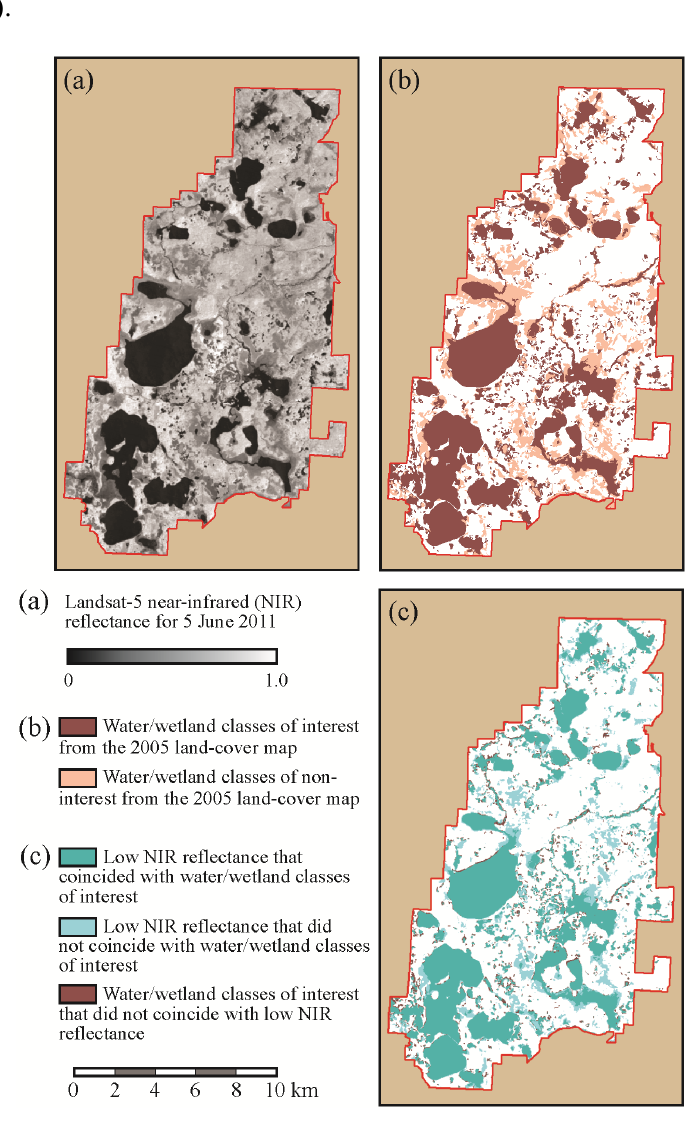
Figure 4. Comparison of early-season near-infrared (NIR) band reflectance ( a ) in 2011 with the distribution of water/wetlands from the 2005 land-cover map; ( b ) Low values of NIR reflectance ( ≤ 0.24 for this Landsat image date) coincided well with areas of water/wetlands; ( c ) including types of interest and those not targeted for the current study (refer to Table